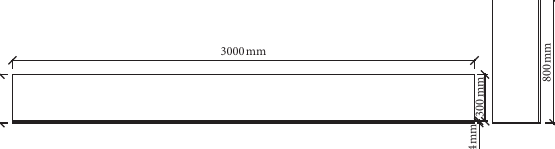
Figure 3: Specimen